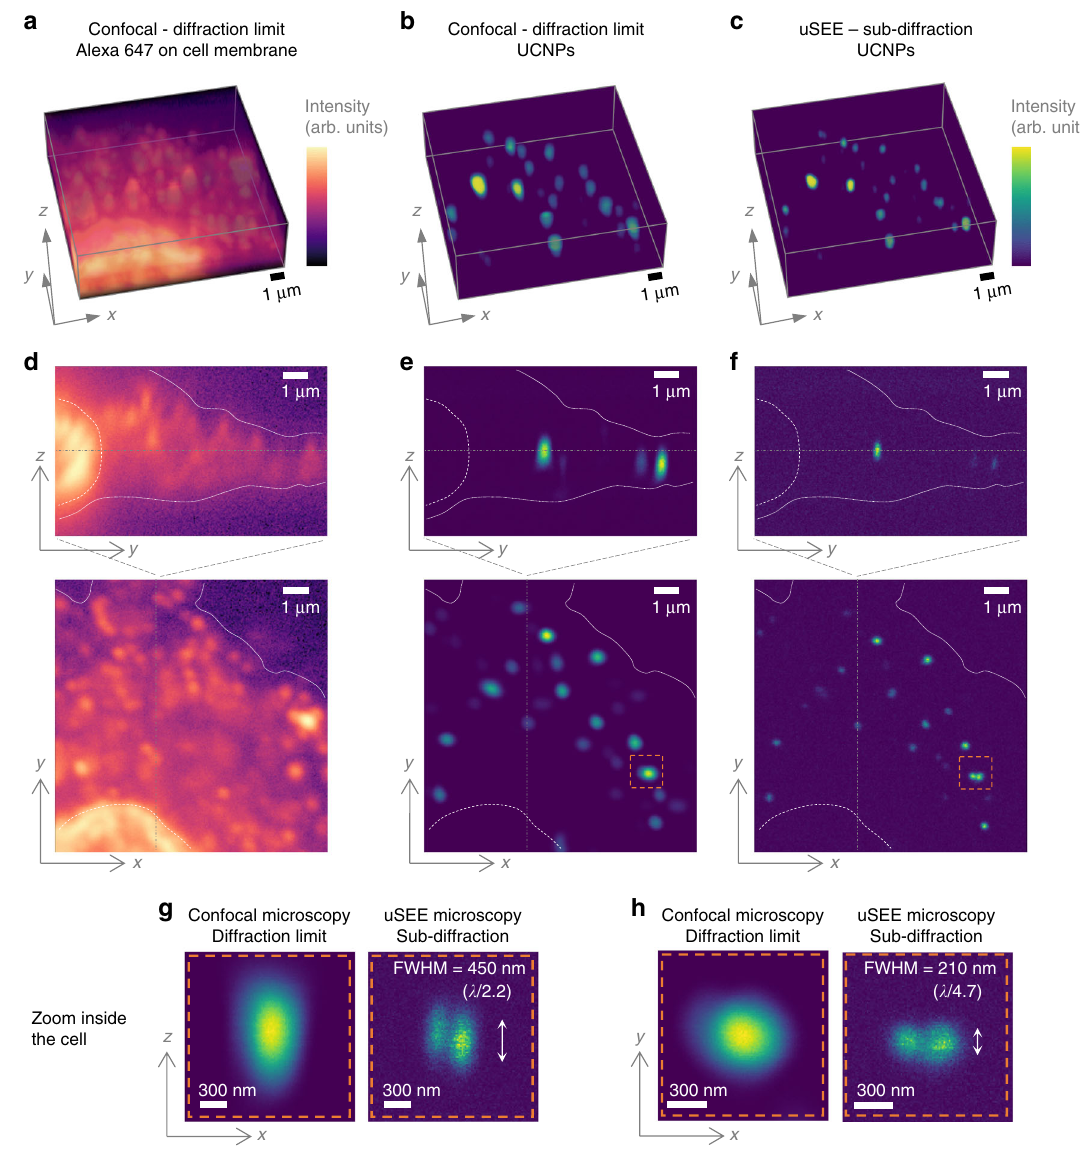
Fig. 5 3D sub-diffraction uSEE microscopy imaging in neuronal cells. A confocally imaged 3D z- stack of a cell incubated with colominic acid functionalized UCNPs ( a - c ). a WGA-Alexa Fluor 647, highlighting the cell plasma membrane. b Confocal images of the UCNPs inside the cell taken at excitation power density corresponding to the lateral diffraction limit (11.8 mW μ m − 2 ). c Confocal images of the UCNPs inside the cell taken at low powers (1.7 mW μ m − 2 ), corresponding to sub-diffraction uSEE microscopy. Corresponding axial and lateral cross sections through the 3D z- stacks are shown in ( d – f ). The gray lines indicate the position of the mutually perpendicular cross sections. The dashed white line frames the cell membrane and the dotted white line highlights the nuclei. Closed in zoom on particles inside the cell (orange-dashed volume in ( e , f )) con fi rms a resolution twice better than the diffraction limit both in axial ( g ) and lateral ( h )